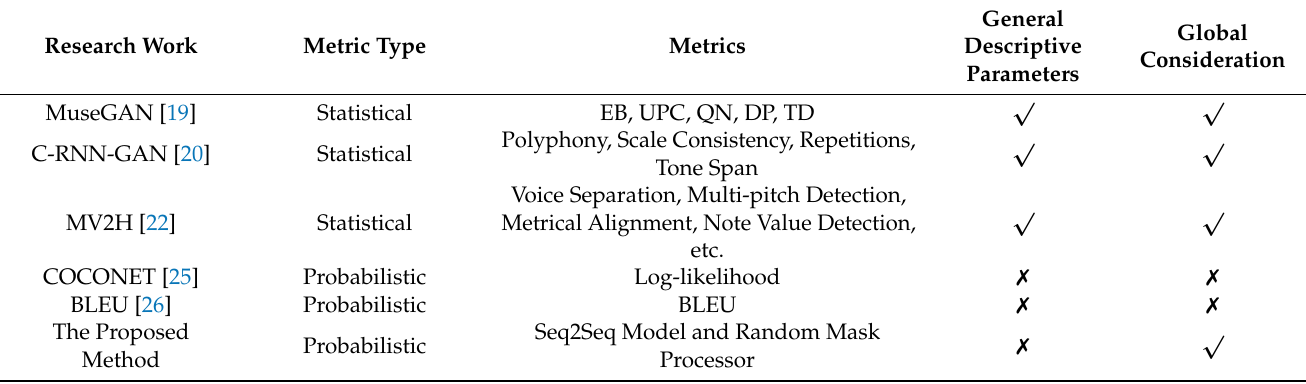
Table 1. Differences between previous approaches and the proposed